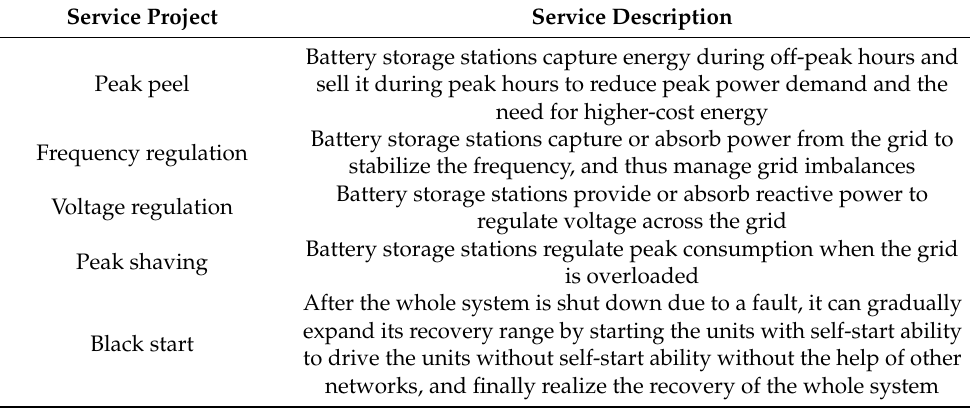
Table 1. Categories of ancillary services.